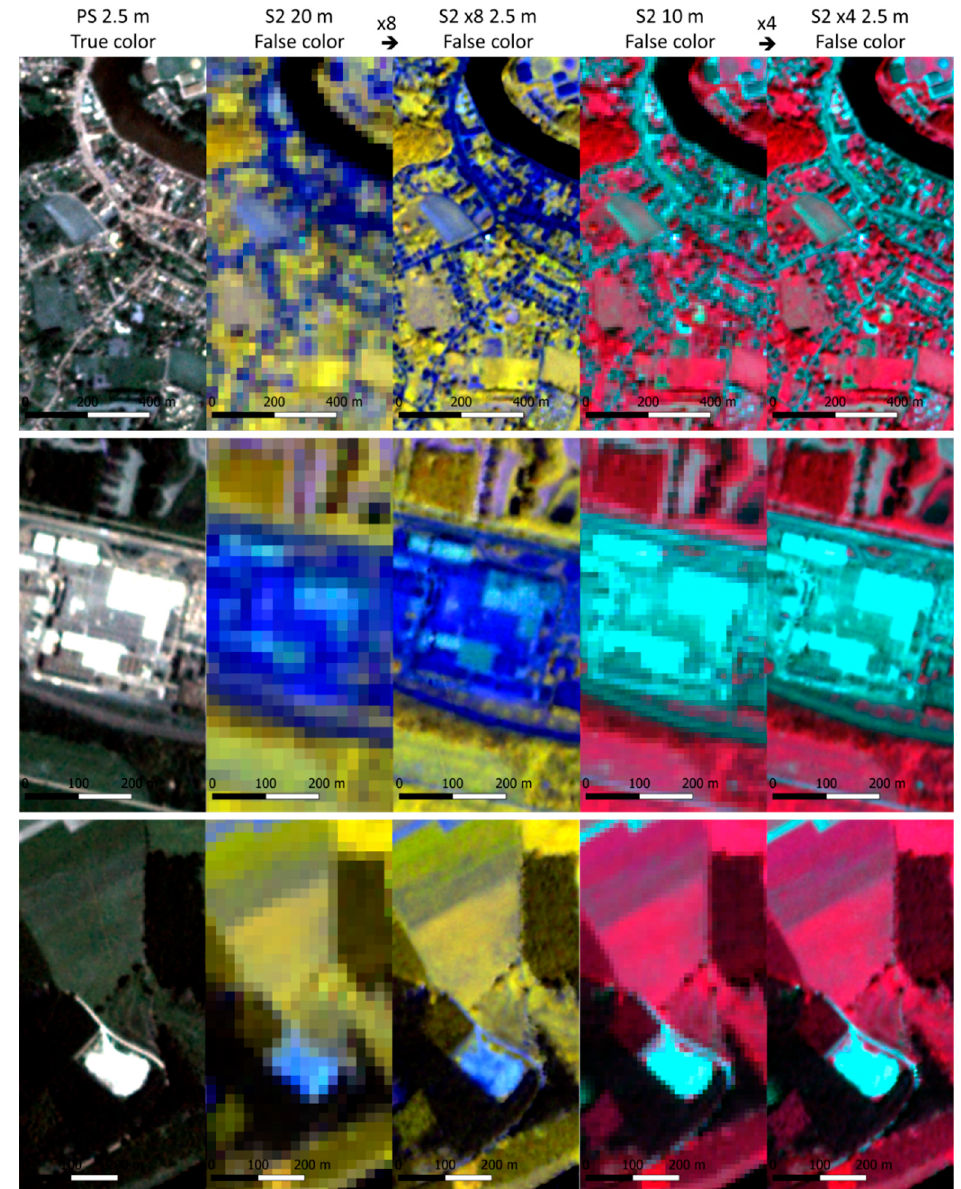
Figure 7. Super ‐ resolved images resulting from the two neural networks (NNs), from 10 to 2.5 m (×4) and from 20 to 2.5 m (×8). PS, PlanetScope; S2, Sentinel ‐ 2. (Top) urban area with a river; (Middle) zoom on industrial buildings; and (Bottom) agricultural land and forest. From left to right: PS at 2.5 m in true color (R, G, and B); S2 at 20 and 2.5 m in false color (B8a, B6, and B12); and S2 at 10 and 2.5 m in false color (B8, B4, and B3).